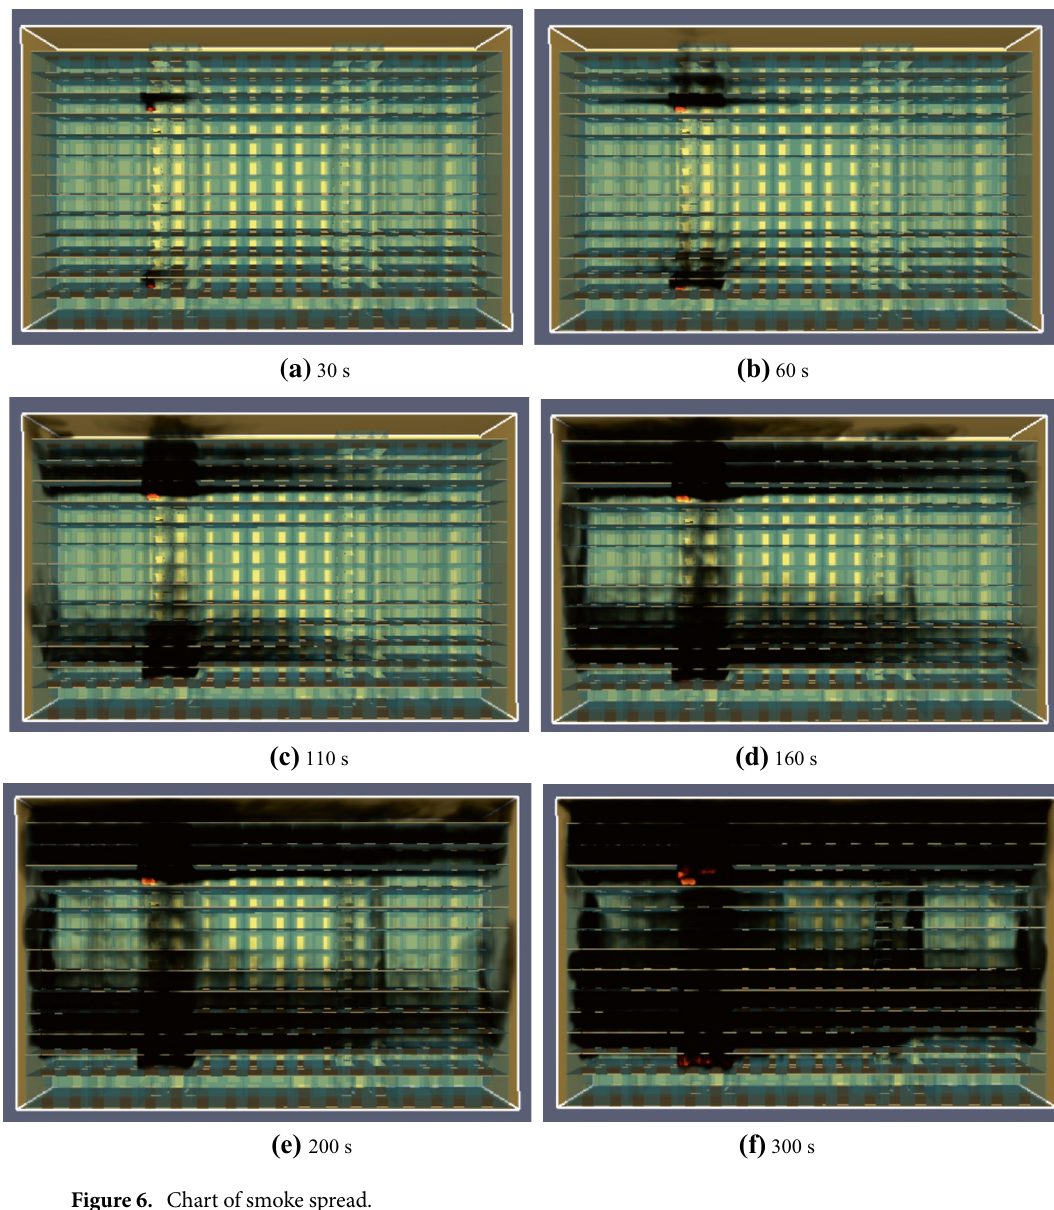
Figure 6. Chart of smoke